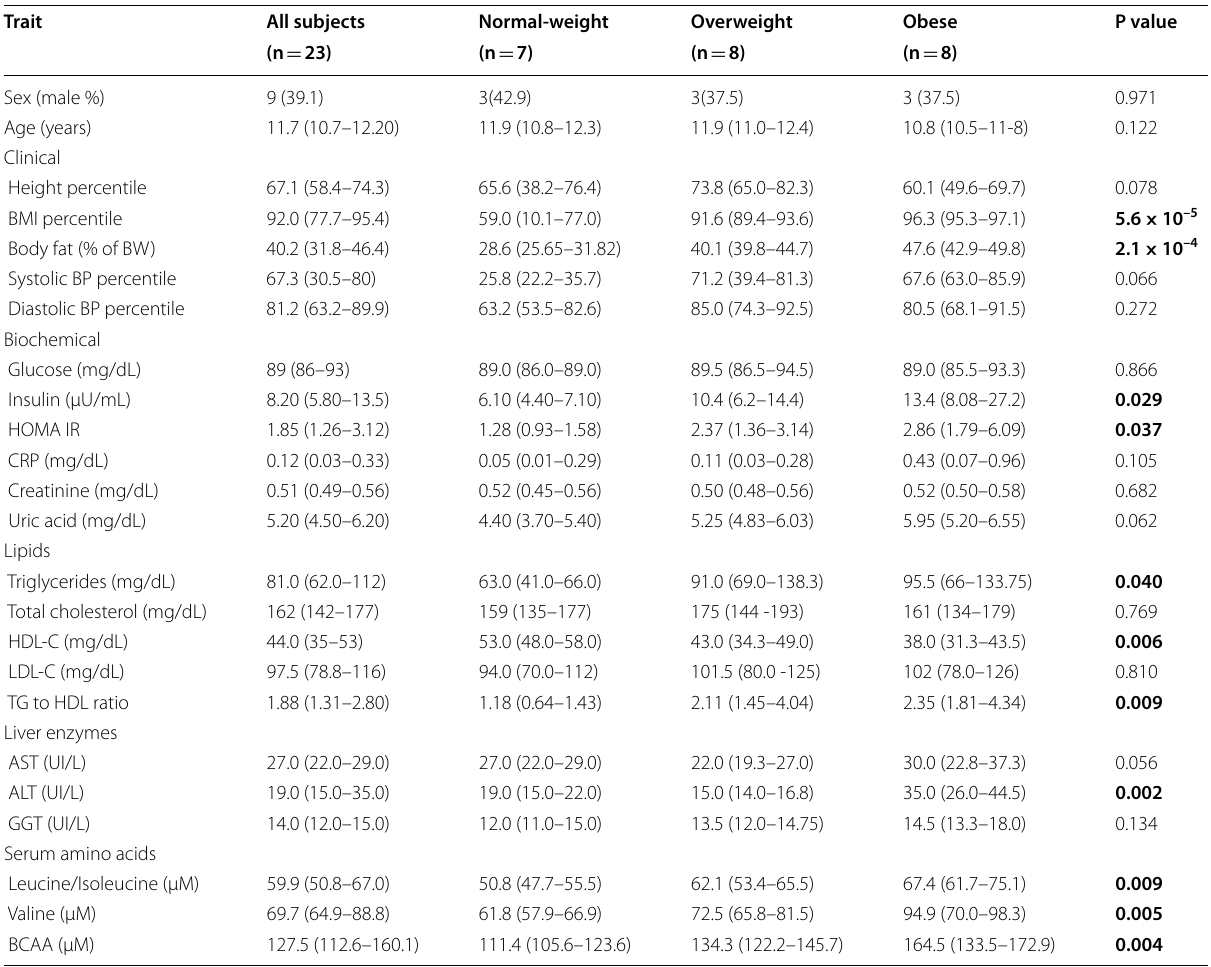
Table 1 Clinical and biochemical characteristics of the study